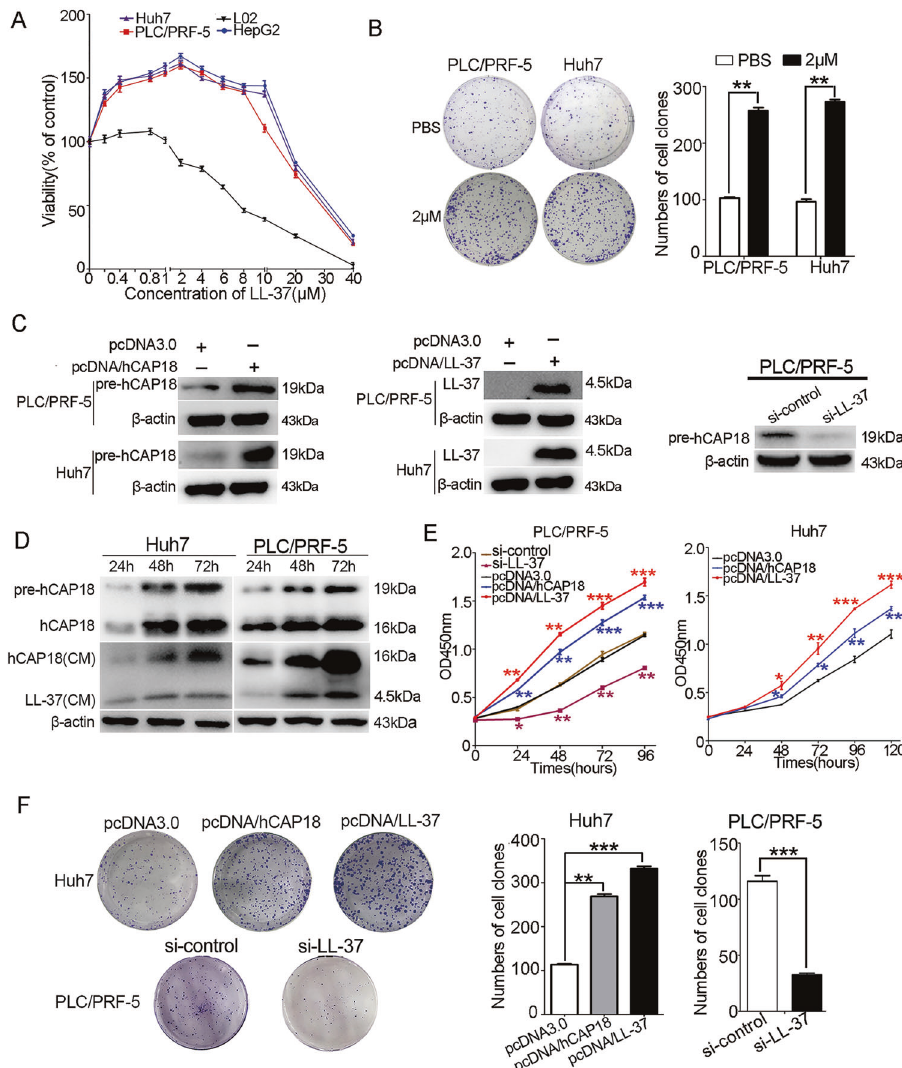
Fig. 2 Effect of hCAP18/LL-37 on the HCC cells growth. A CCK-8 assay was conducted in PLC/PRF-5, Huh7, HepG2, and L02 cells after treatment with different concentrations (0 – 40 μ M) of LL-37 for 24 h. B Effect of LL-37 (2 μ M) on the colony formation detected by clone formation assays. C Huh7 and PLC/PRF-5 cells were transfected with pcDNA/hCAP18, pcDNA/LL-37, or si-LL-37 for 48 h, respectively. Ef fi ciency of hCAP18/LL-37 overexpression or knockdown in PLC/PRF-5 and Huh7 cells was detected by western blotting. D Levels of pre-hCAP18 (~19 kDa), hCAP18 (~16 kDa), and LL-37 (~4.5 kDa) were detected after transfection with pcDNA/hCAP18 for 24 h, 48 h, 72 h, and 96 h. The effect on cell growth ( E ) and survival ( F ) were detected by CCK-8 assay and colony formation assay after transfection with pcDNA/hCAP18, pcDNA/LL-37, or si-LL-37. Data represent the mean ± SEM for 4 – 6 independent experiments. CM: culture medium. * p < 0.05, ** p < 0.01, and *** p <